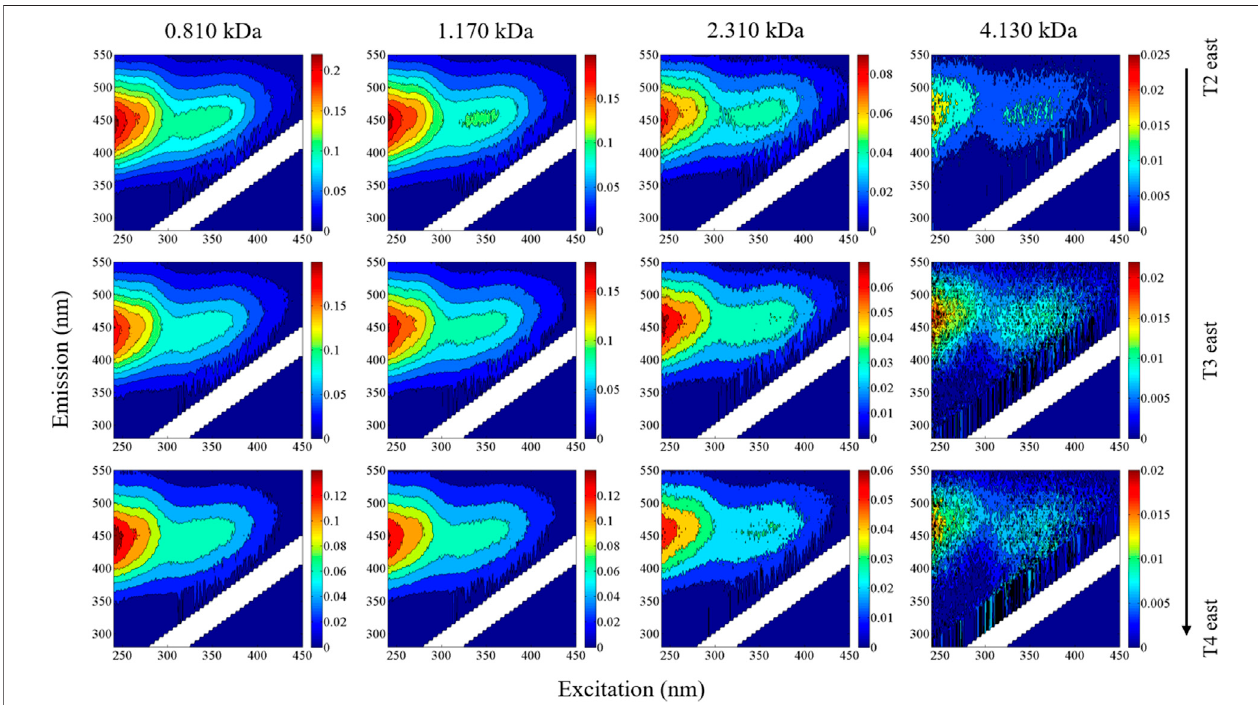
FIGURE 6 | Evolution of size-resolved EEMs along the east side of the LAR. The T2 – T4 site locations are identi fi ed in Figure 5 . Fluorescence intensities are normalized to Raman units (r.u.).